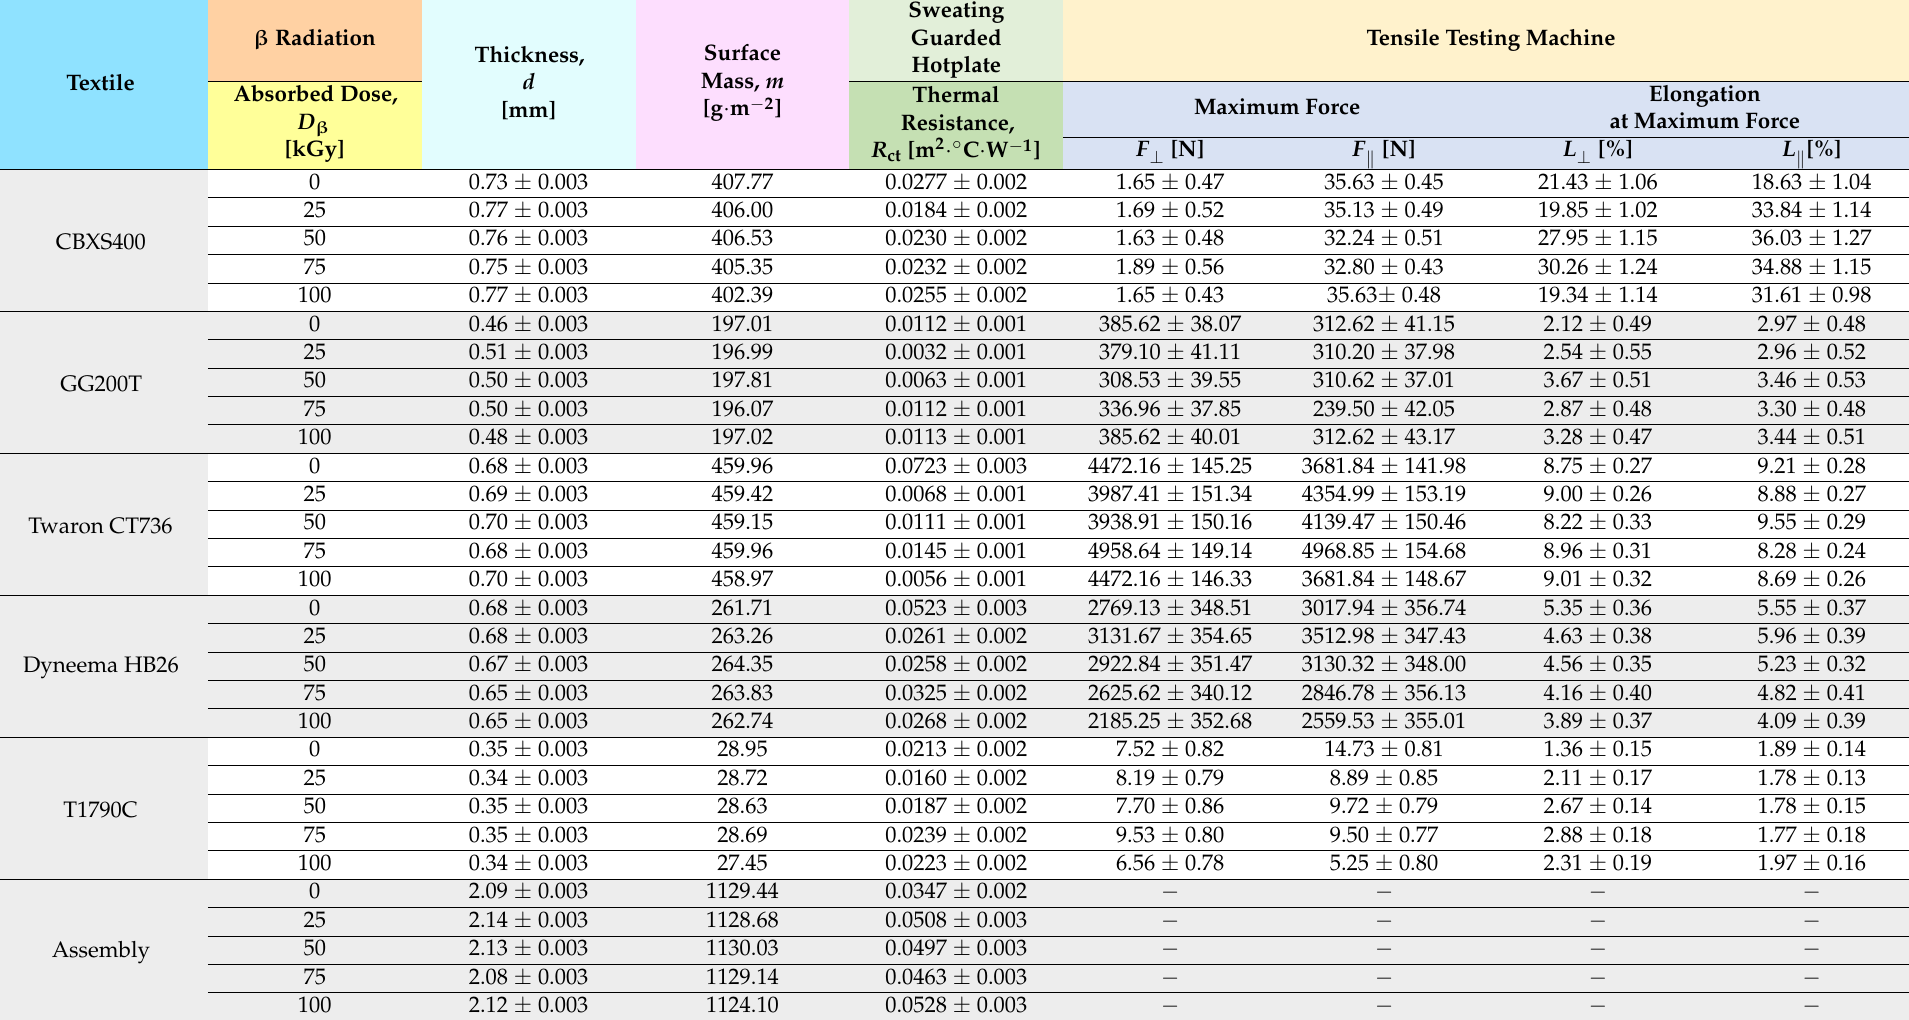
Table 5. Structural, biophysical and mechanical properties of unmodified and β -irradiated textiles. β